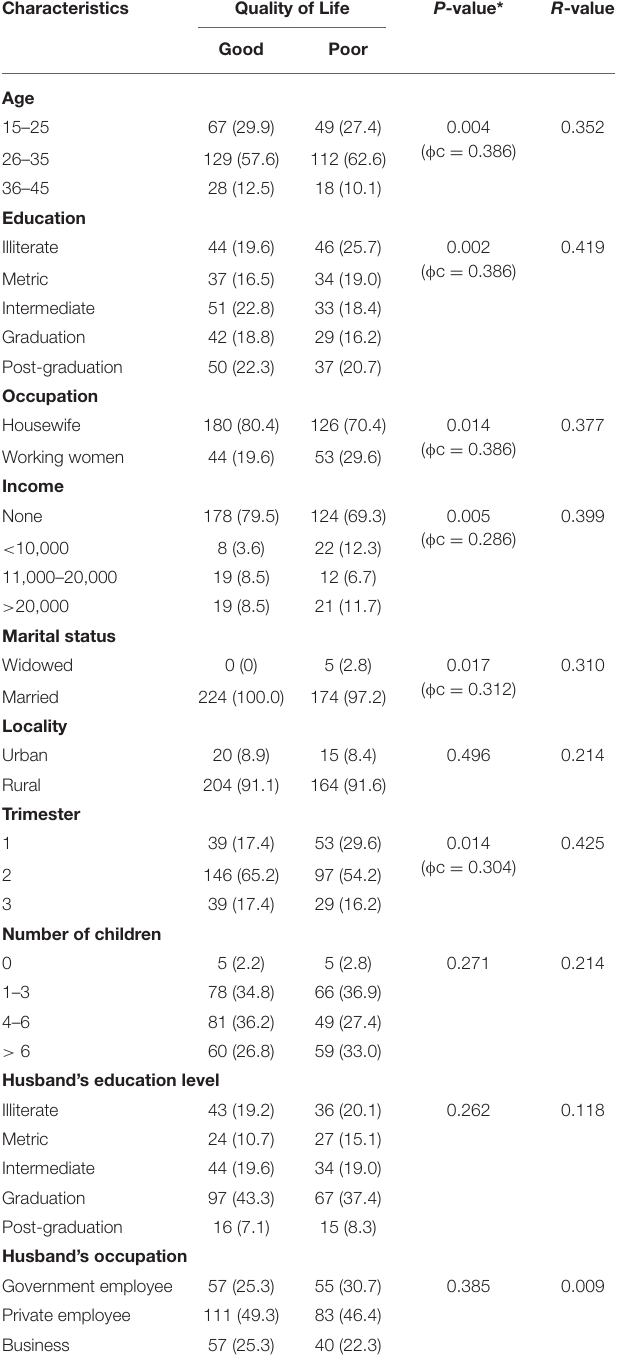
TABLE 3 | Patients’ demographics characteristics and Quality of Life. TABLE 4 | Factor associated with Quality of Life among pregnant women. Model Standardized